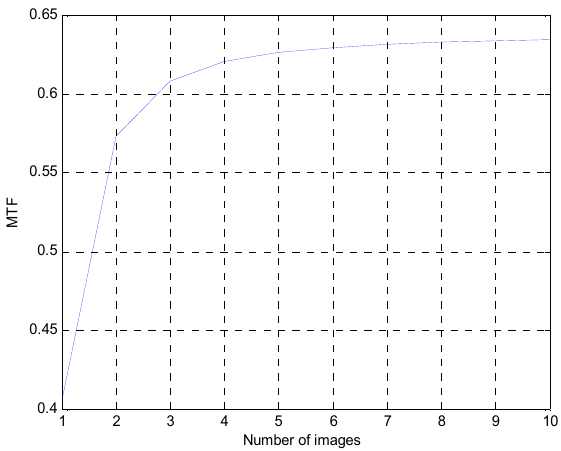
Figure 9. MTF simulation result of the subpixel imaging system with multiple images.